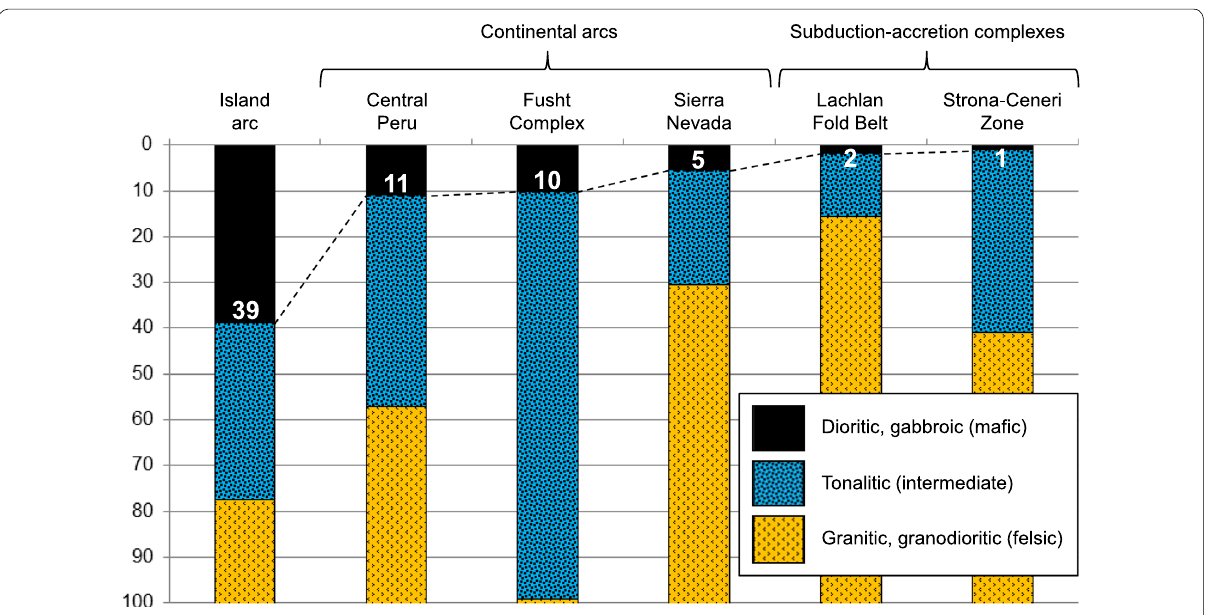
Fig. 9 Percentages of mafic (indicated by numbers), intermediate and felsic intrusiva in batholiths of three different settings: (i) island arc, (ii) continental arc and (iii) subduction–accretion complex. Data are from Villaseca et al. (1998), Hauser and Zurbriggen (1994) for the Fusht Complex, and Zurbriggen (2015) for the Strona-Ceneri